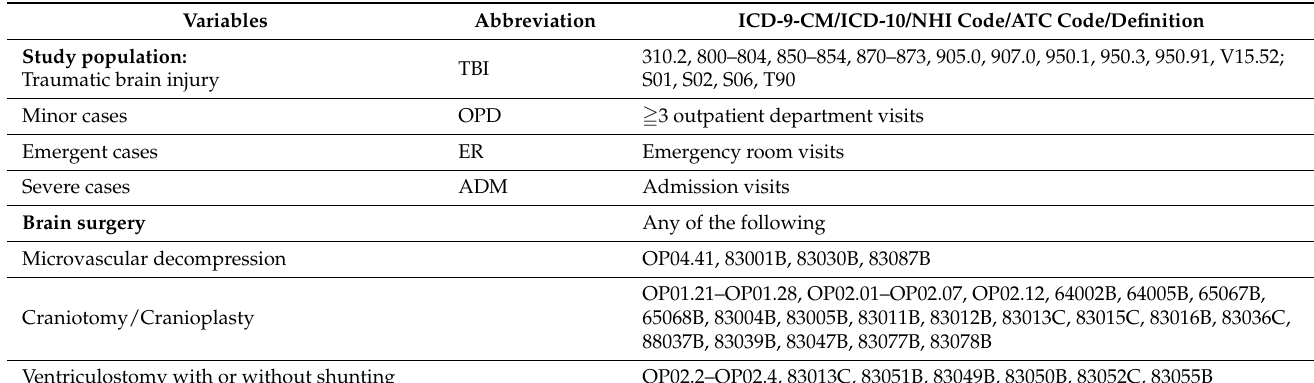
Table A1. Diagnostic codes ( ICD-9-CM and ICD-10-CM codes) for the inclusion and exclusion variables and NHI and ATC codes for